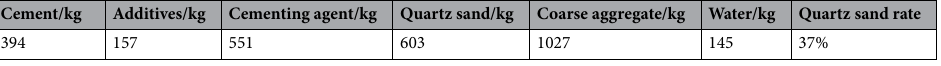
Table 1. The mix proportion for C60 concrete.